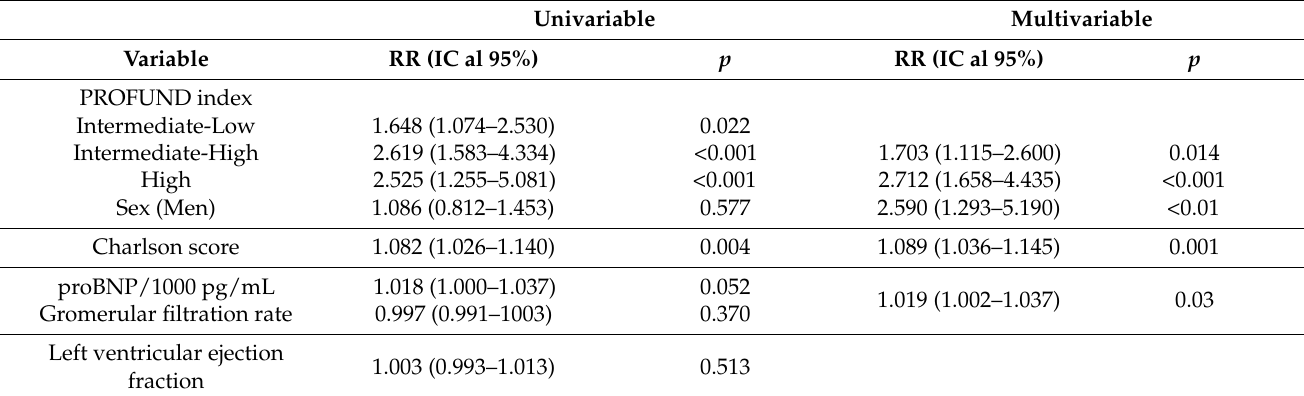
Table 3. COX regression analysis of mortality at one